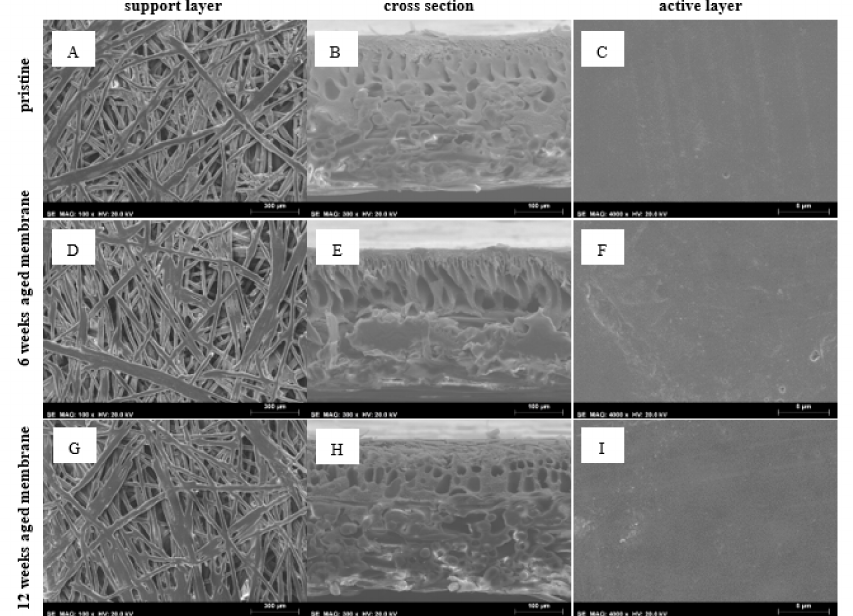
Figure 4. SEM analysis for the polymeric membrane. ( A ) Pristine membrane support layer; ( B ) pris- tine membrane cross-section; ( C ) pristine membrane active layer; ( D ) 6 weeks aged membrane support layer; ( E ) 6 weeks aged membrane cross-section; ( F ) 6 weeks aged membrane active layer; ( G ) 12 weeks aged membrane support layer; ( H ) 12 weeks aged membrane cross-section; ( I ) 12 weeks aged membrane active layer. Support layer magnification is × 100, cross-section magnification is × 300 and active layer magnification is ×